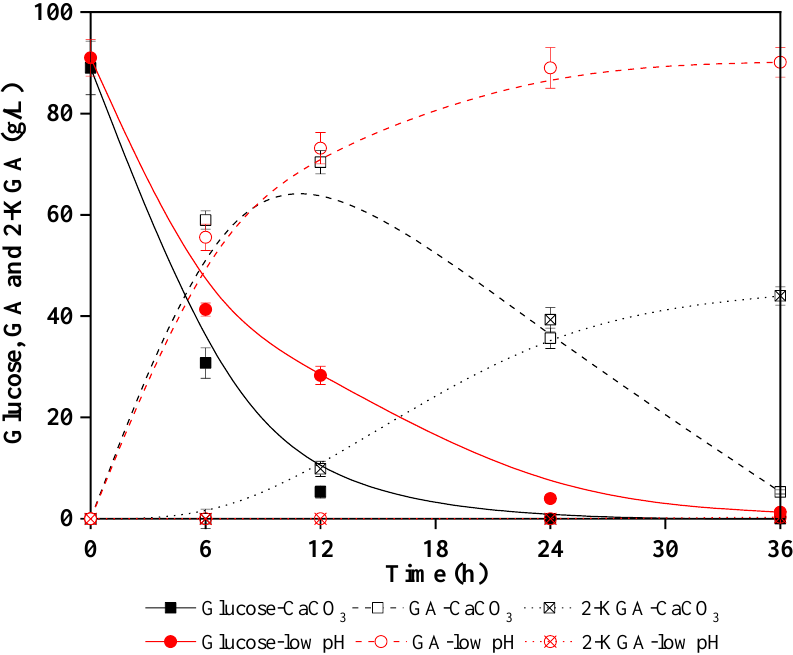
Figure 3. Comparison of Gluconobacter oxydans performance in GA (gluconic acid) and 2-KGA (2-ketogluconic acid) production from corncob hydrolysates under a low pH environment and a slightly acidic pH environment.